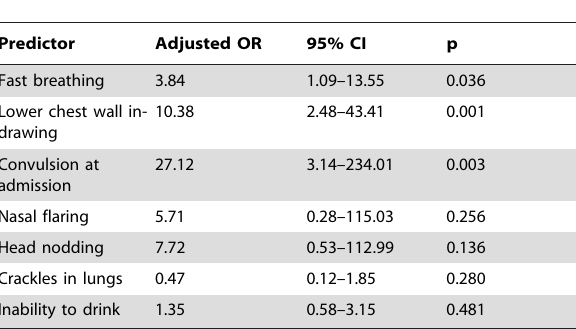
Table 2. Results of logistic regression to explore the independent predictors of hypoxemia in under-five SAM children with